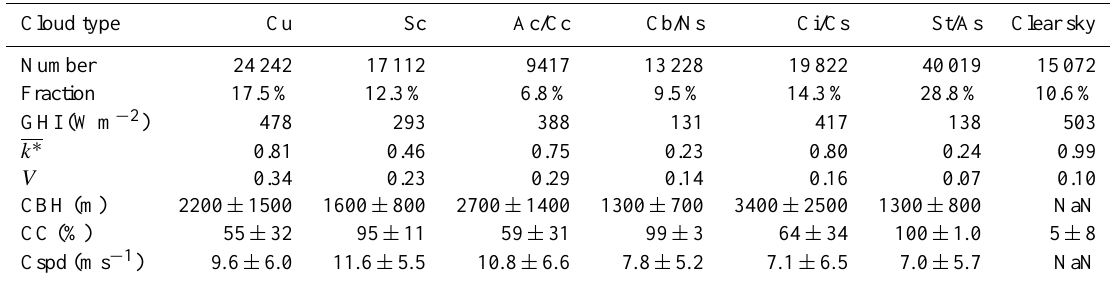
Table 1. Results of cloud type classification. The first two rows give the frequency of occurrence and its share of the total number of analysed images. k ∗ and V represent the corresponding k ∗ statistics (average, variability) of station 33, which had the highest number of valid measurements during the period. Average and standard deviation are given for the measured cloud base height (CBH), the analysed hemispheric cloud coverage (CC) and cloud motion speed